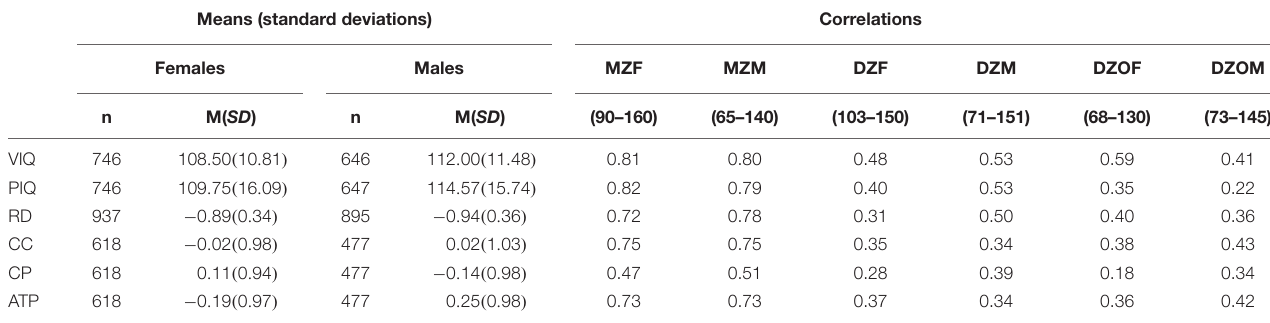
FIGURE 1 | Path diagram of hypothesized model. Note: No specific hypotheses are made regarding the unique environmental structure. These paths are omitted for clarity. VIQ, verbal IQ; PIQ, performance IQ; RD, reading; Comprehend and Collect, comprehend and collect; CP, create and present; ATP, apply techniques and procedures. TABLE 1 | Mean and standard deviation of variables for females and males, and twin correlations according to